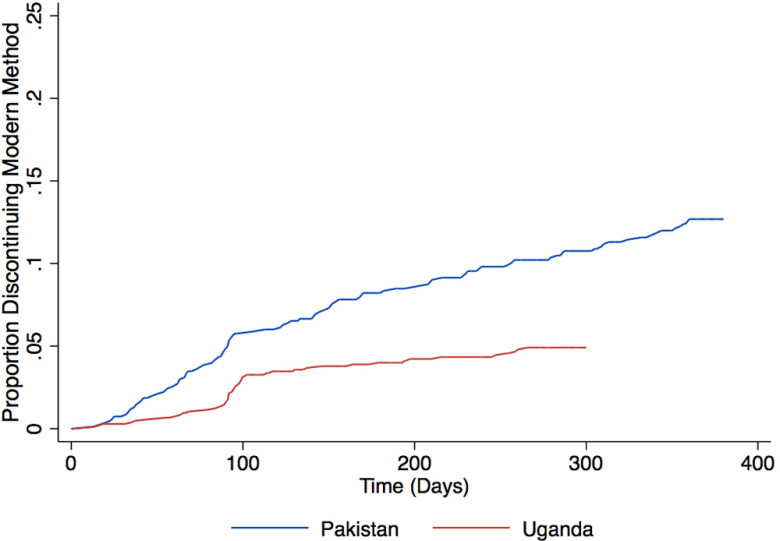
Cumulative Probability of Modern Method Discontinuation Among Women in Need in Pakistan and Uganda